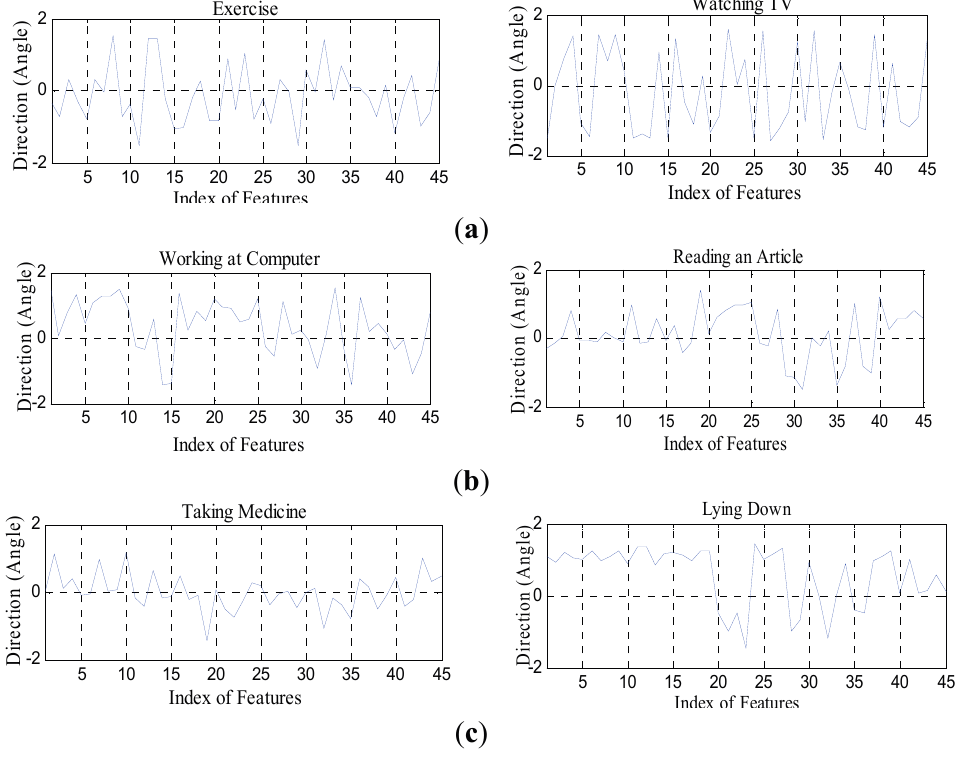
Figure 6. Directional angular features from the joint points of the body parts of human activities under the indoor environments. ( a ) smart home activities, ( b ) smart office activities and ( c ) smart hospital activities.